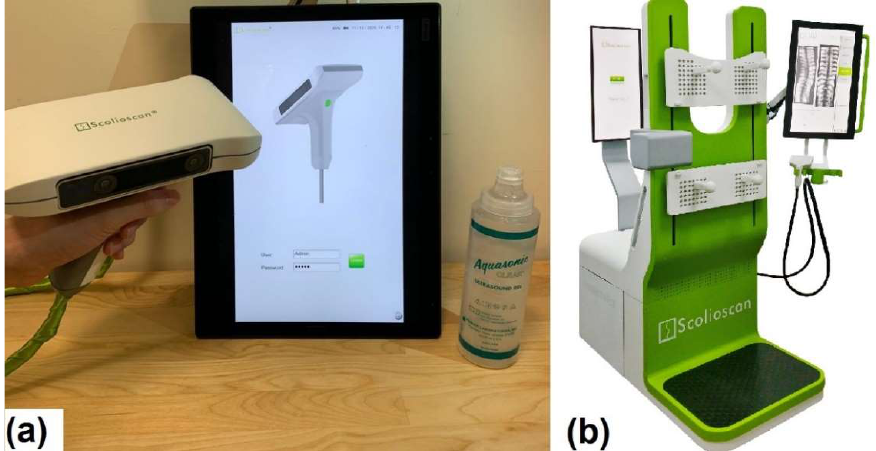
Figure 1. Pictures showing ( a ) portable 3D ultrasound imaging system Scolioscan Air and ( b ) con- ventional 3D ultrasound imaging system Scolioscan [53].